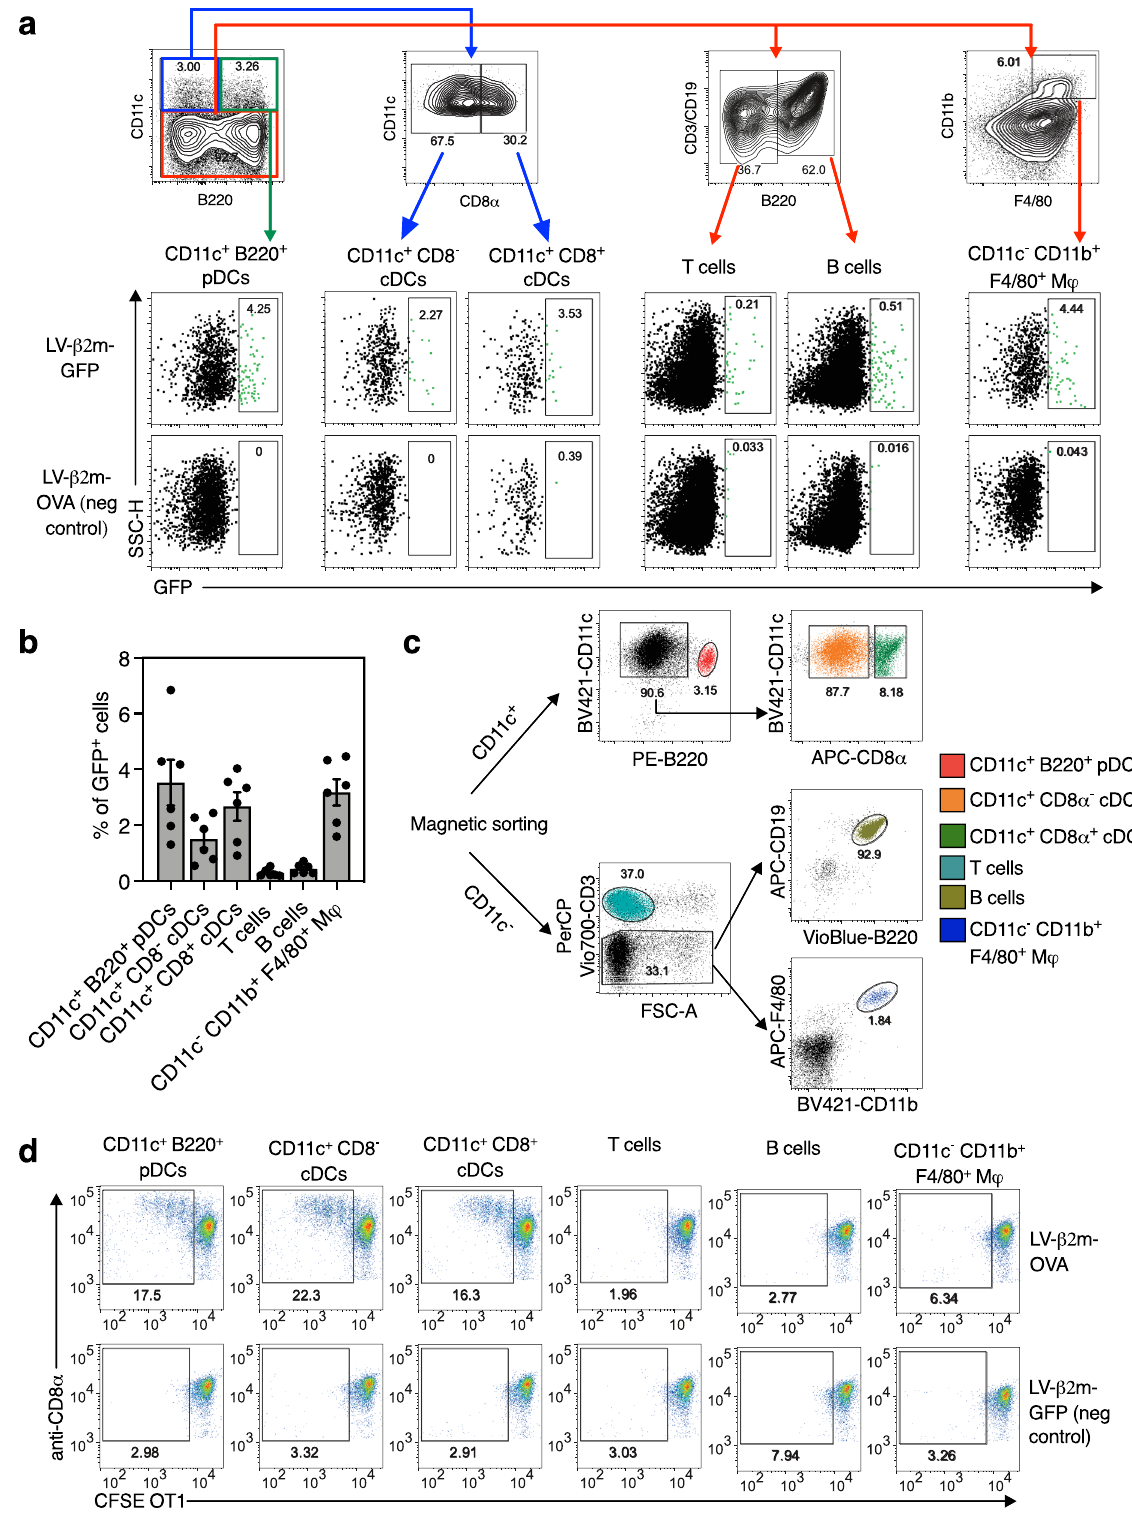
LV- β 2m-EsxH induced a signi fi cantly higher percentage of triple positive CD8 + T cells than Ad5-CMV-EsxH, at 28 and 90 dpi (Fig. 5c and Supplementary Fig. 5c). Altogether, these results show that compared to Ad5, the lentiviral vector triggers CD8 + T-cell responses with higher degrees of polyfunctionality, both at the early and late time points